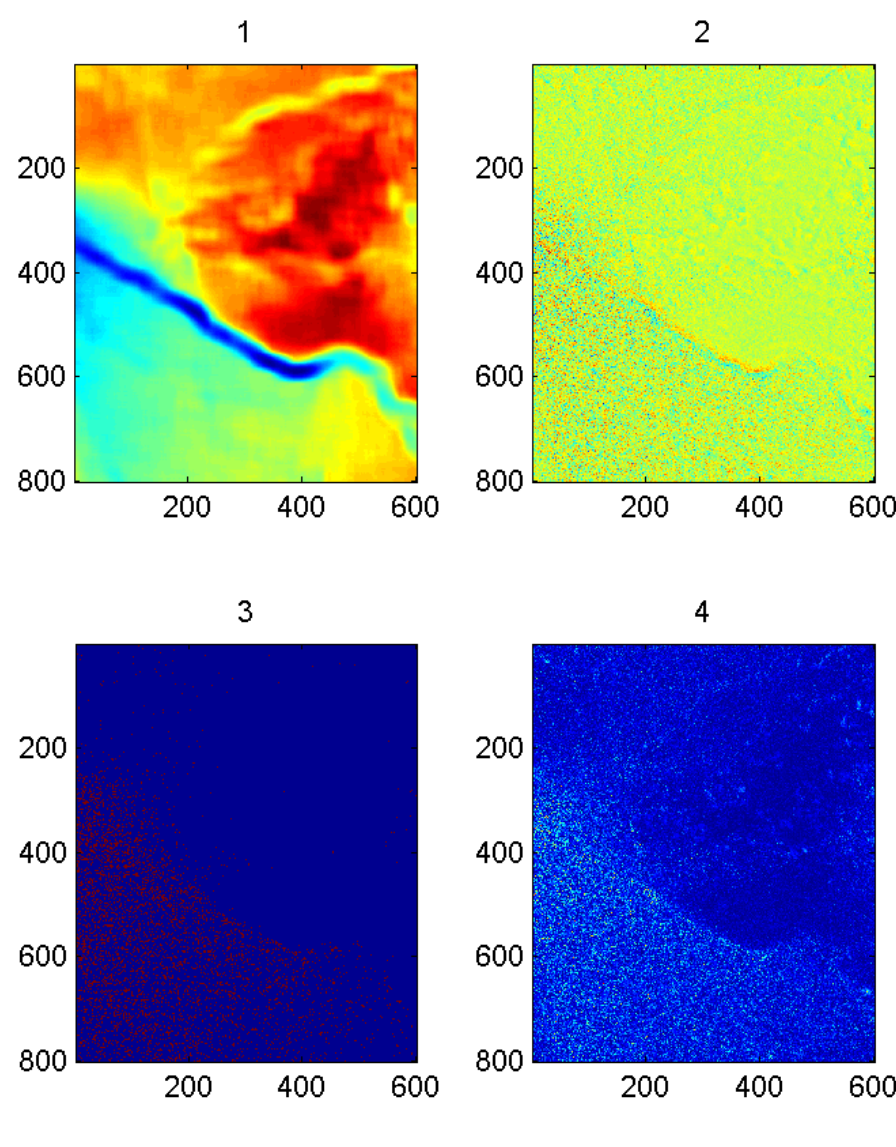
Figure 9. Each subimage is a Varimax rotated score map for the case study, 0533 UTC on December 9, 2007. The first shows the fronts as blue or yellow bands, the second shows the sharp edge of the strongest front as parallel blue and red lines. The third and fourth subimages show noise. The axes are labeled in pixel